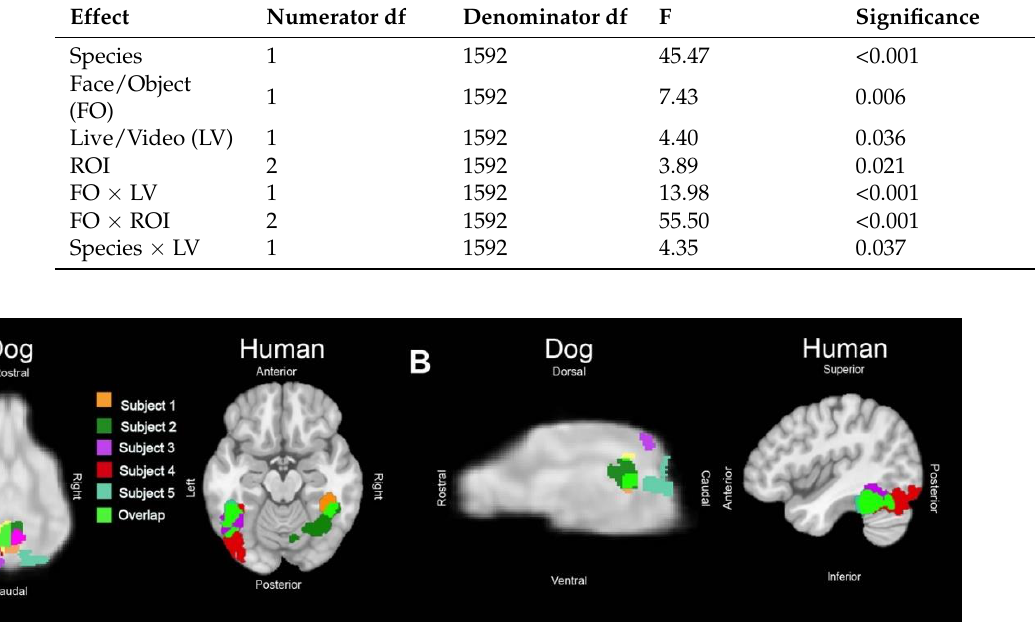
Table 1. Results of the mixed-model analysis of the ROIs.